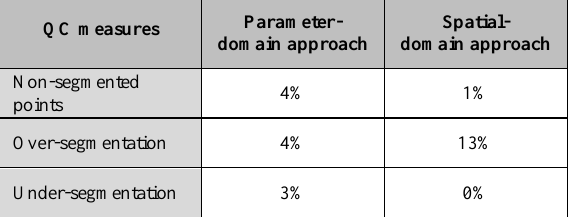
Table 2. Derived quality control measures for the parameter- domain and spatial-domain segmentation results of the static terrestrial laser scanning